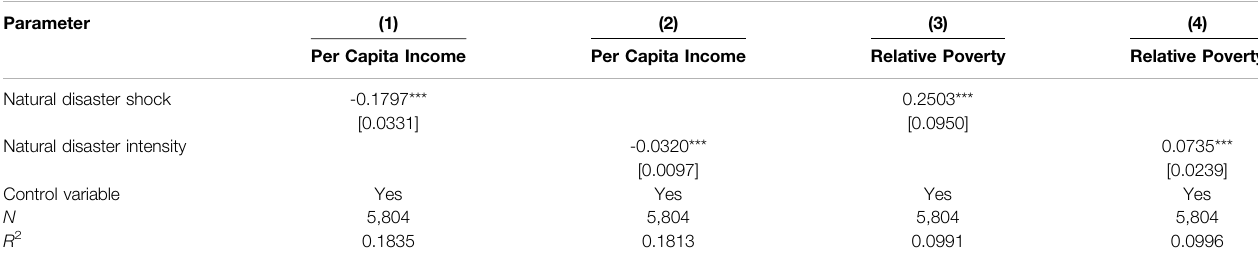
TABLE 4 | Robustness test